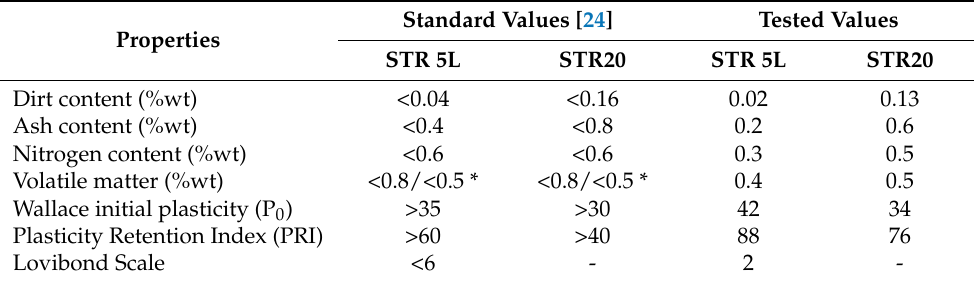
Table 6. Properties of microwave-dried tested samples against the specifications of the STR5L and STR20 block rubber